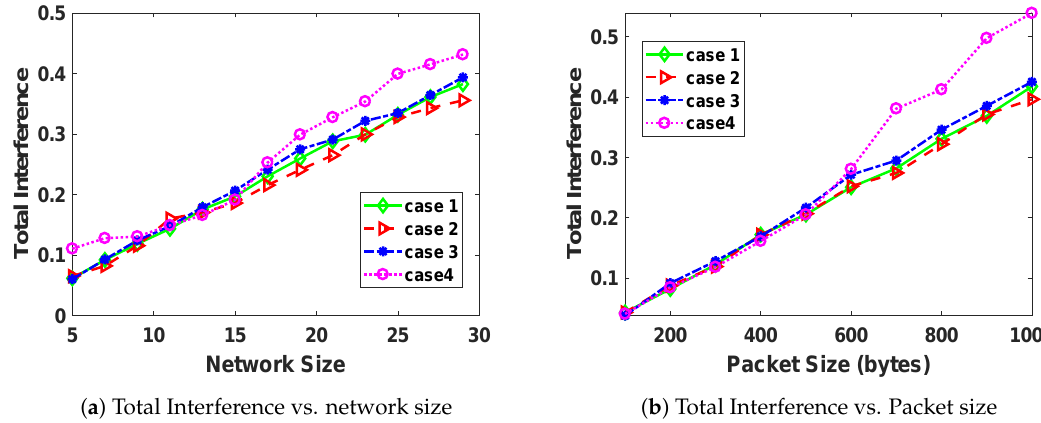
Figure 5. Effect of network size and packet size on the total interference.